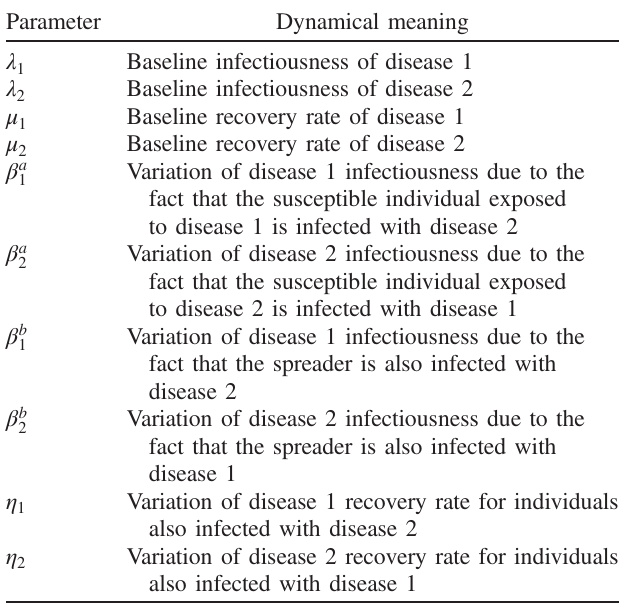
TABLE I. Definition of model parameters.